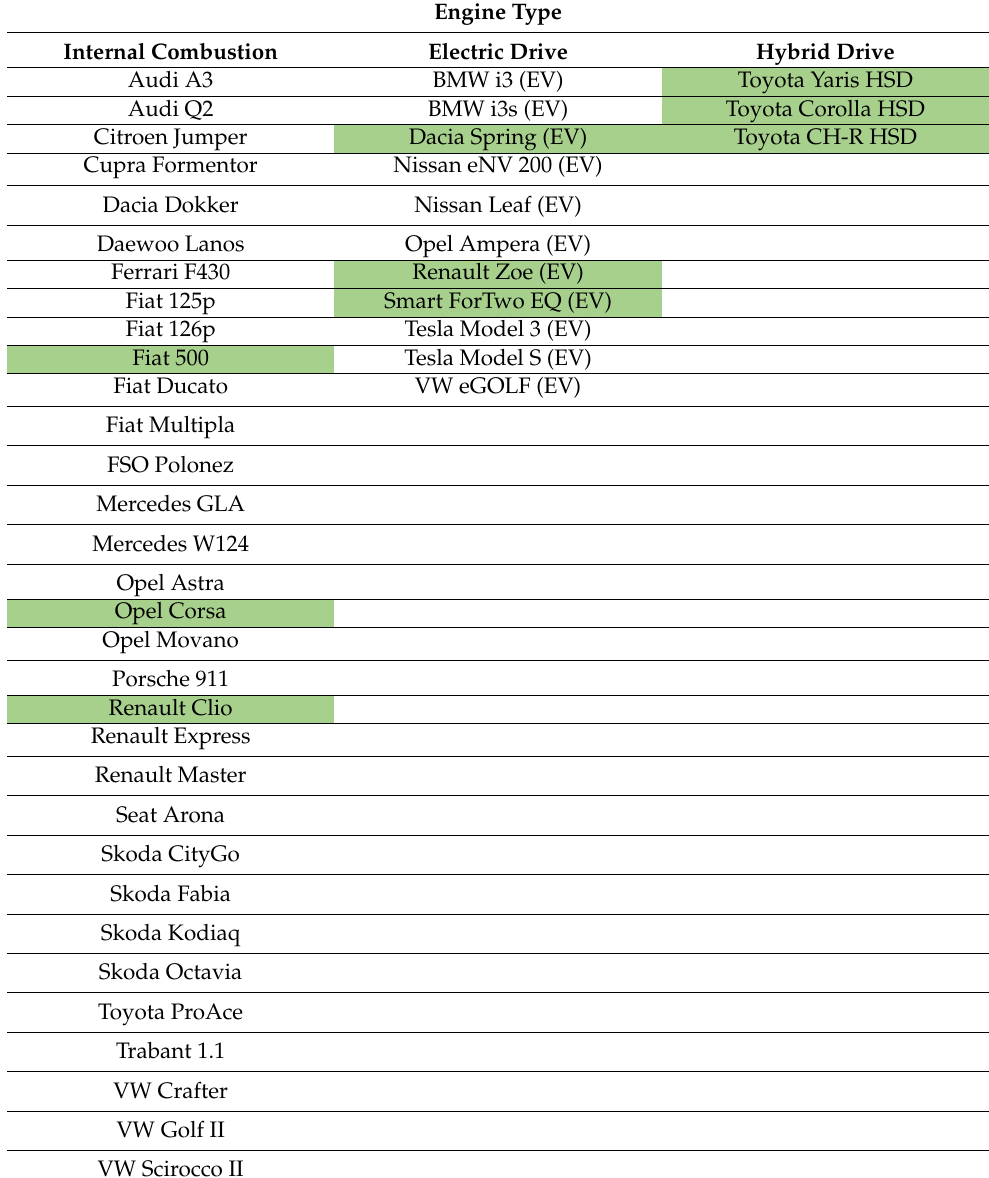
Table 1. Vehicles used in Polish car-sharing